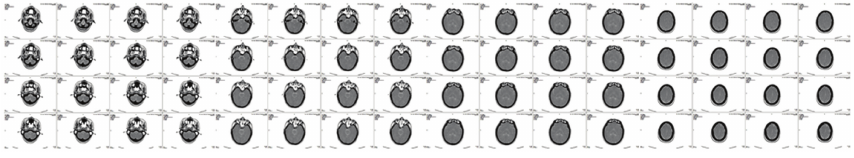
Figure 13: CT scan image of cranial cavity.